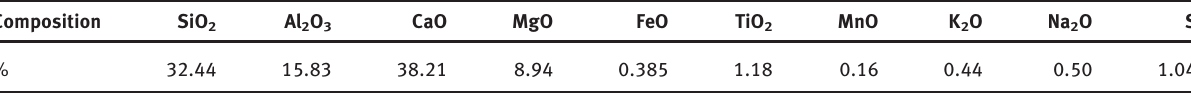
Table 1: The composition of 4,000 m 3 blast furnace slag in M steel. Composition